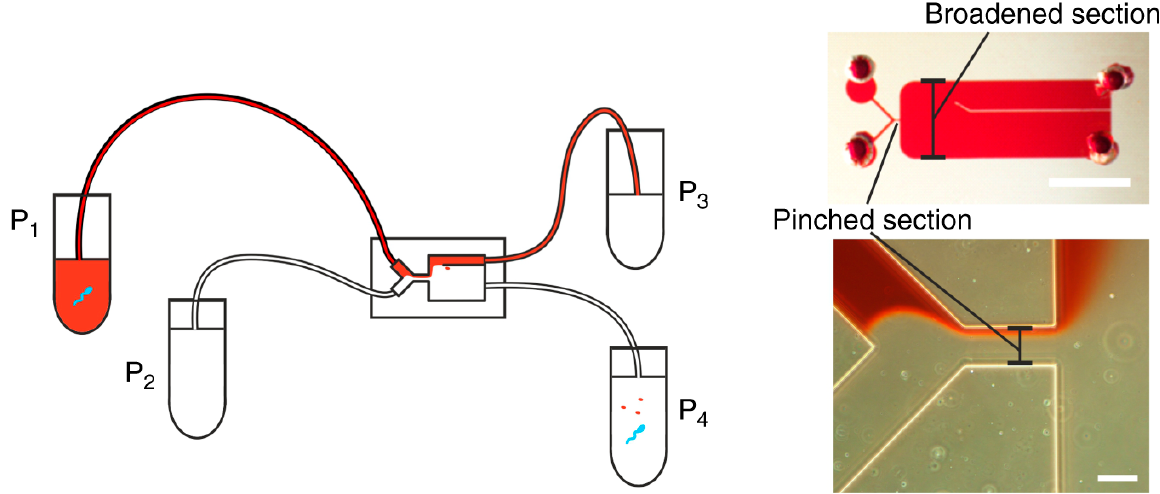
Figure 1. Pinched-flow fractionation (PFF) chip using a tumbling mechanism. The figure has been reproduced with permission from Springer Nature [69].